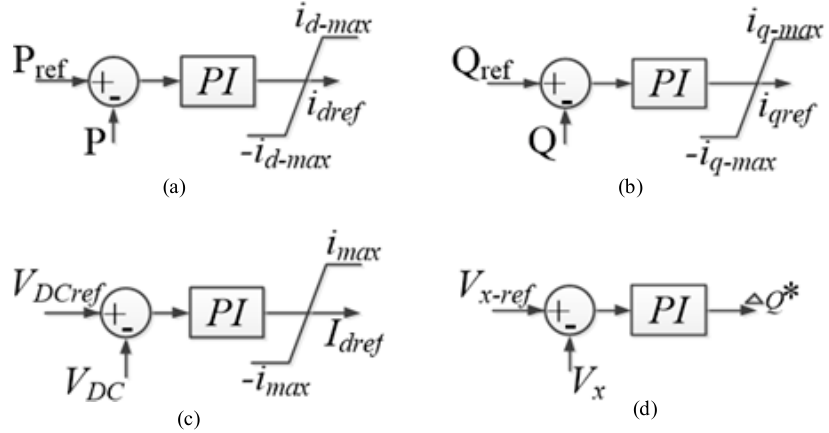
Figure 5. Control for ( a ) active power, ( b ) reactive power, ( c ) DC voltage control, and ( d ) DC voltage control.